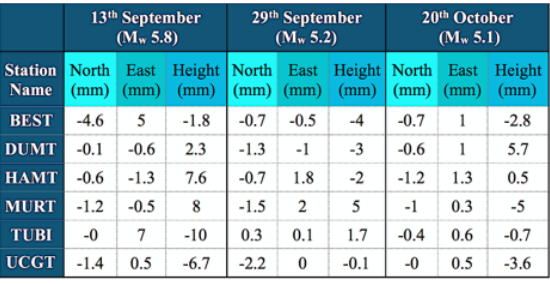
Table 2: CGPS station displacements during the 13 th and 29 th September and 20 th October 1999 aftershocks.